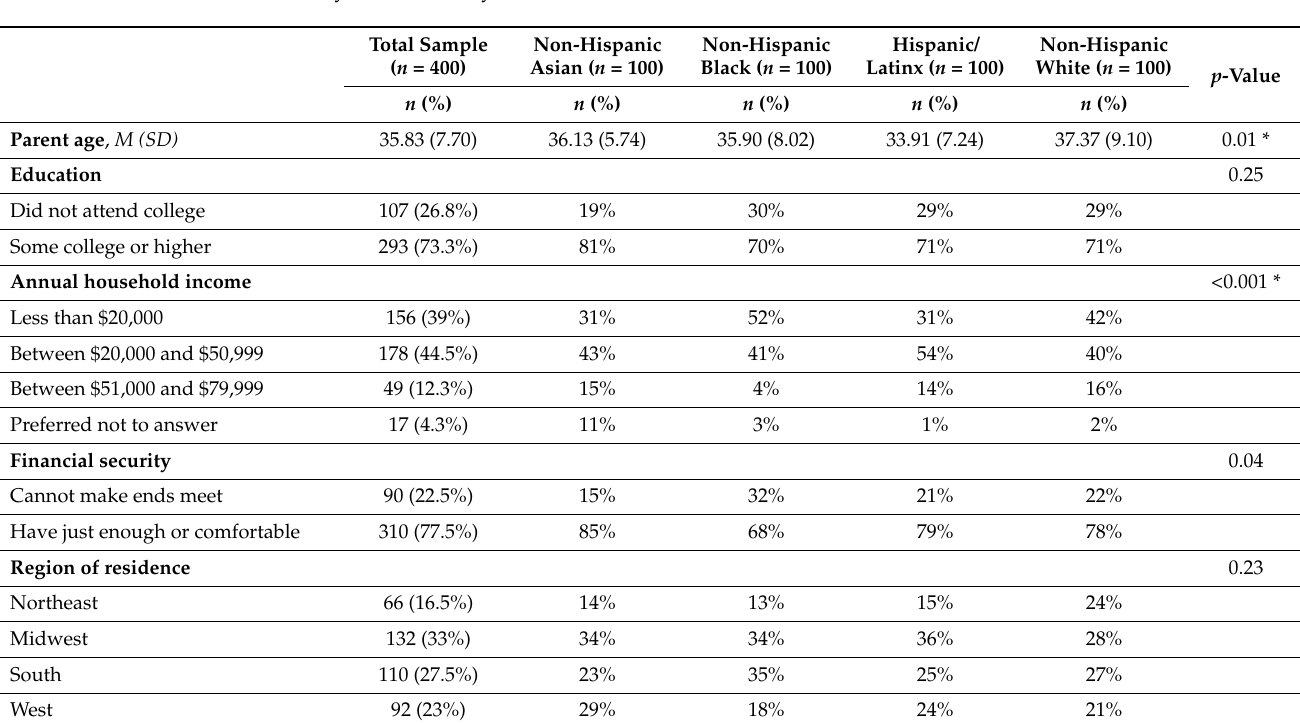
Table 2. Frequencies and percentages for parent and child characteristics, plans to vaccinate child against COVID-19, and factors influencing COVID-19 vaccine hesitancy and acceptability by